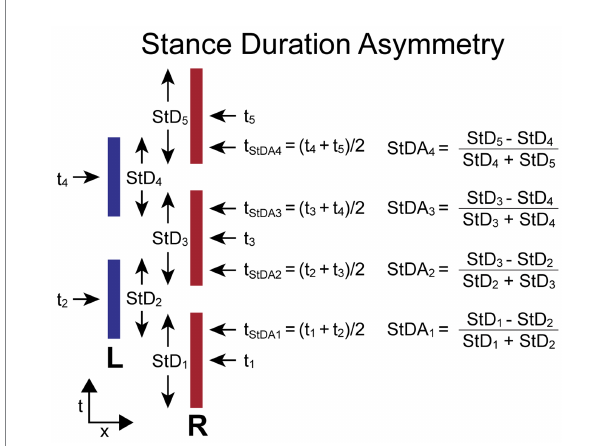
FIGURE 4 Stance Duration Asymmetry ( StDA ) calculation parameters and formula. Times t i are the times at the midpoint in time when a foot is in contact with the surface defined as the stance durations ( StD i ). The difference between the values of StD on adjacent steps divided by their sum determines the value of StDA . The time point ( t StDAi ) associated with each StDA measure is the average of the midpoints in time of the right and left stance phases used for the StDA calculation and occurs approximately at the midpoint of the double- leg support phase of gait. The calculations are shown for the condition where the first step is with the right (R) foot and differs from the calculation when the first step is with the left (L) foot so that a positive StDA measure is always indicative of a pattern of stepping where the R foot contact time is greater than the L foot contact